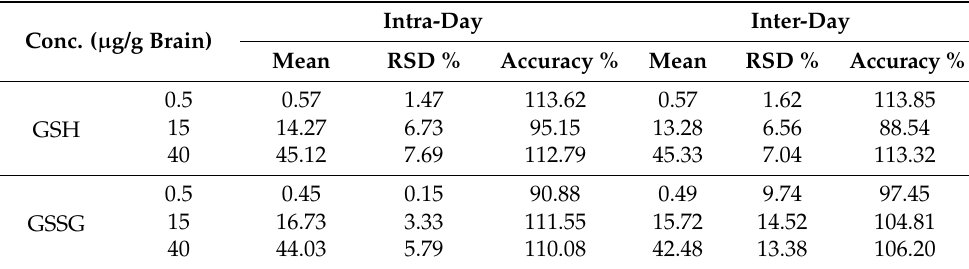
Table 3. Accuracy and precision of reduced glutathione (GSH) and oxidized glutathione (GSSG) in lower limits of quantification and quality control samples.